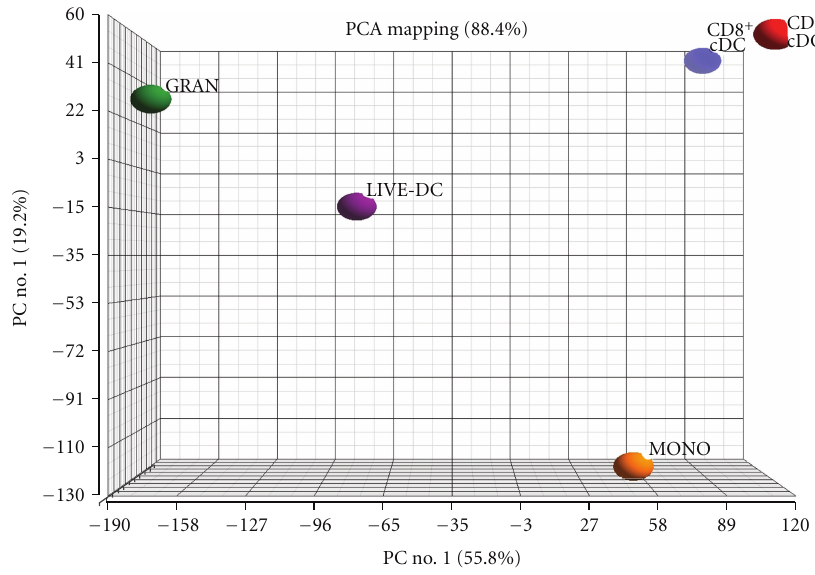
Figure 4: Relatedness of transcriptome between L-DC (LIVE-DC) and other spleen myeloid subsets. Myeloid and DC subsets were isolated from spleen by antibody staining and cell sorting using flow cytometry as demonstrated in Figure 3. RNA was prepared from DC subsets described in Figure 2, and from granulocytes (GRAN) as Gr-1 + CD11b + CD11c − cells and monocytes (MONO) as CD11b + CD11c − MHC-II − cells. RNA was used to probe A ff ymetrix Gene 1.0ST microarrays. Data show Principal Components Analysis (1&2) reflecting degree of relatedness in overall gene expression between